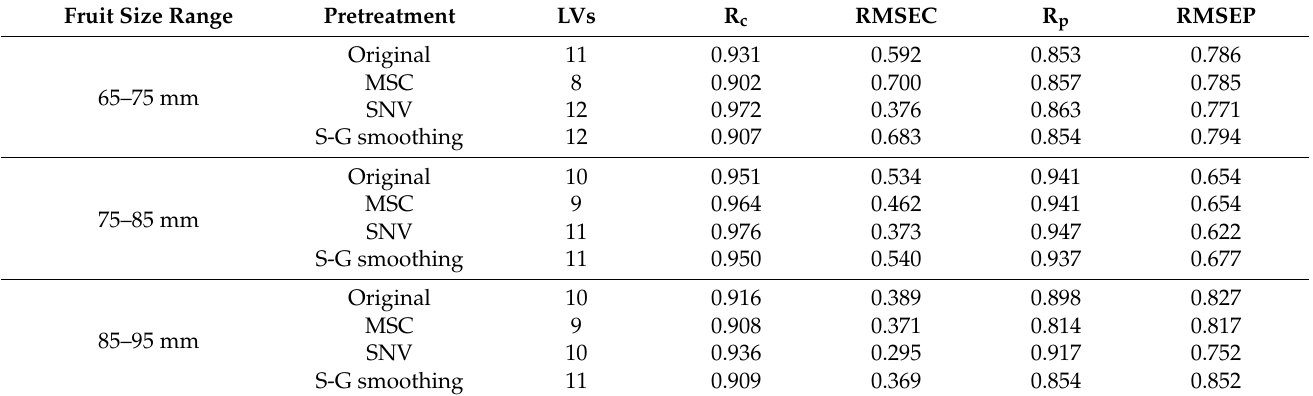
Table 3. PLSR findings for SSC of various apple size groups after spectra pretreatment.